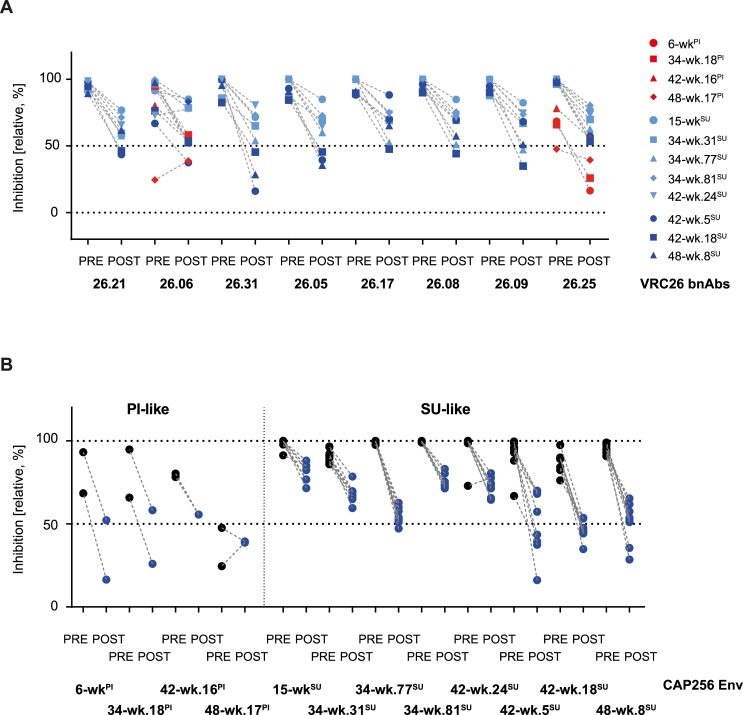
CAP256-VRC26 bnAbs display high activities at the pre- and post-CD4 attachment step.A and B: Pre- and post- CD4 attachment activities of the VRC26 bnAbs are displayed relative to the total activity of each bnAb-virus combination. Data were derived from two independent experiments A: Data displayed are sorted by bnAbs, PI-like, SU-like VRC26 sensitive and SU-like VRC26 early escape viruses are marked in red, light blue and dark blue respectively. B: Same data as in A, sorted by virus strains. Pre- and post-attachment activity are shown in black or blue respectively.